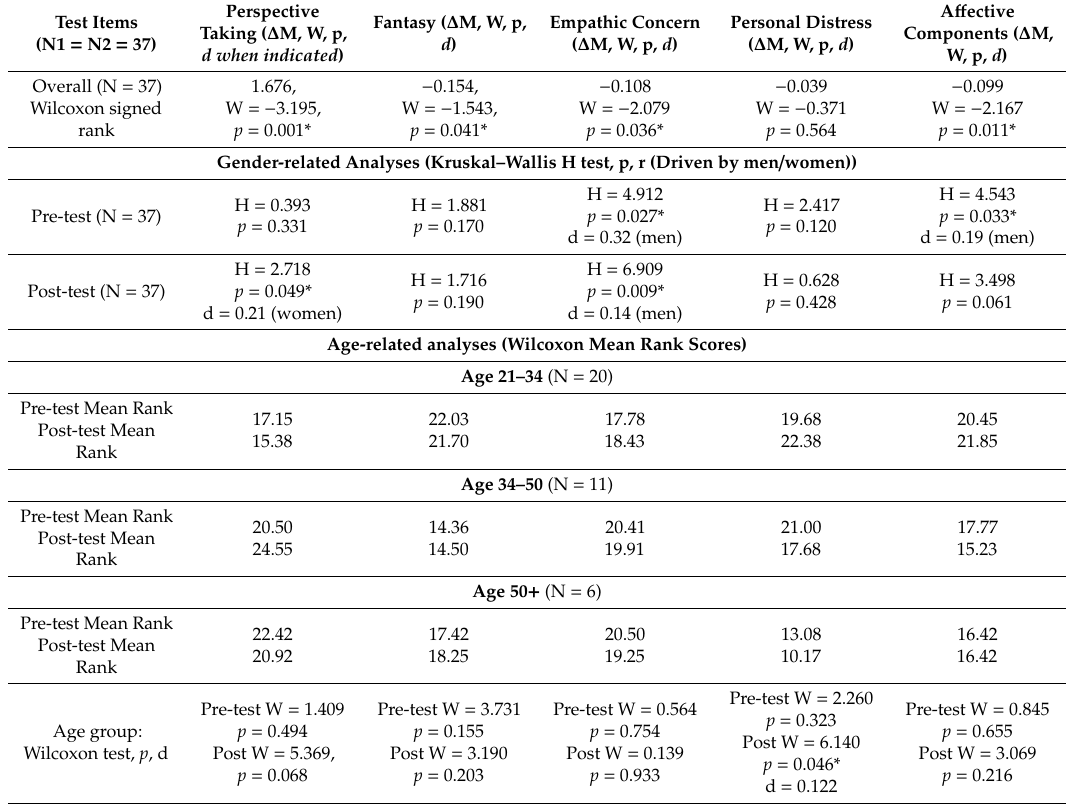
Table 2. Pre- and Post-Experimental Decision Laboratory empathy survey